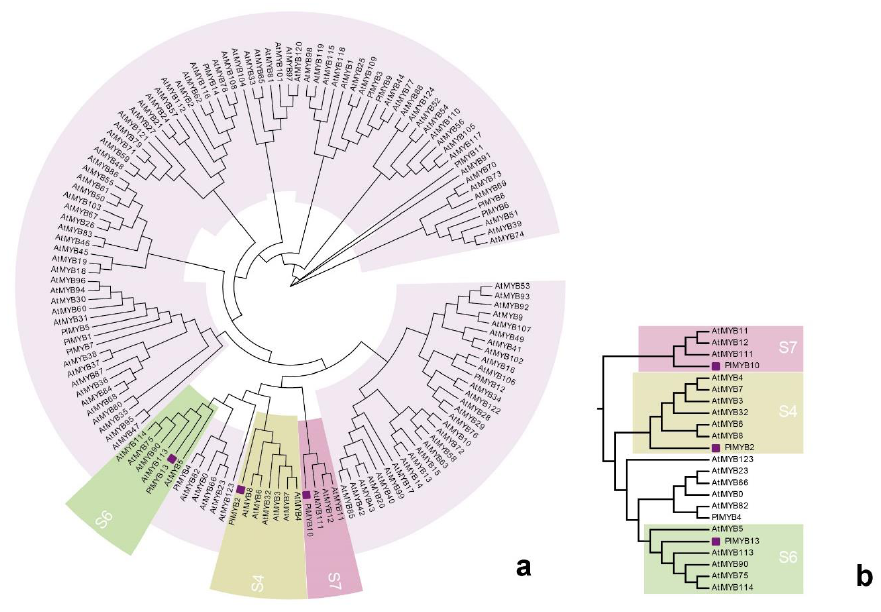
Figure 6. Real time quantitative reverse transcription-PCR of several genes in P. limprichtii . Each value is shown as average ± standard deviation from three biological replicate sampling.